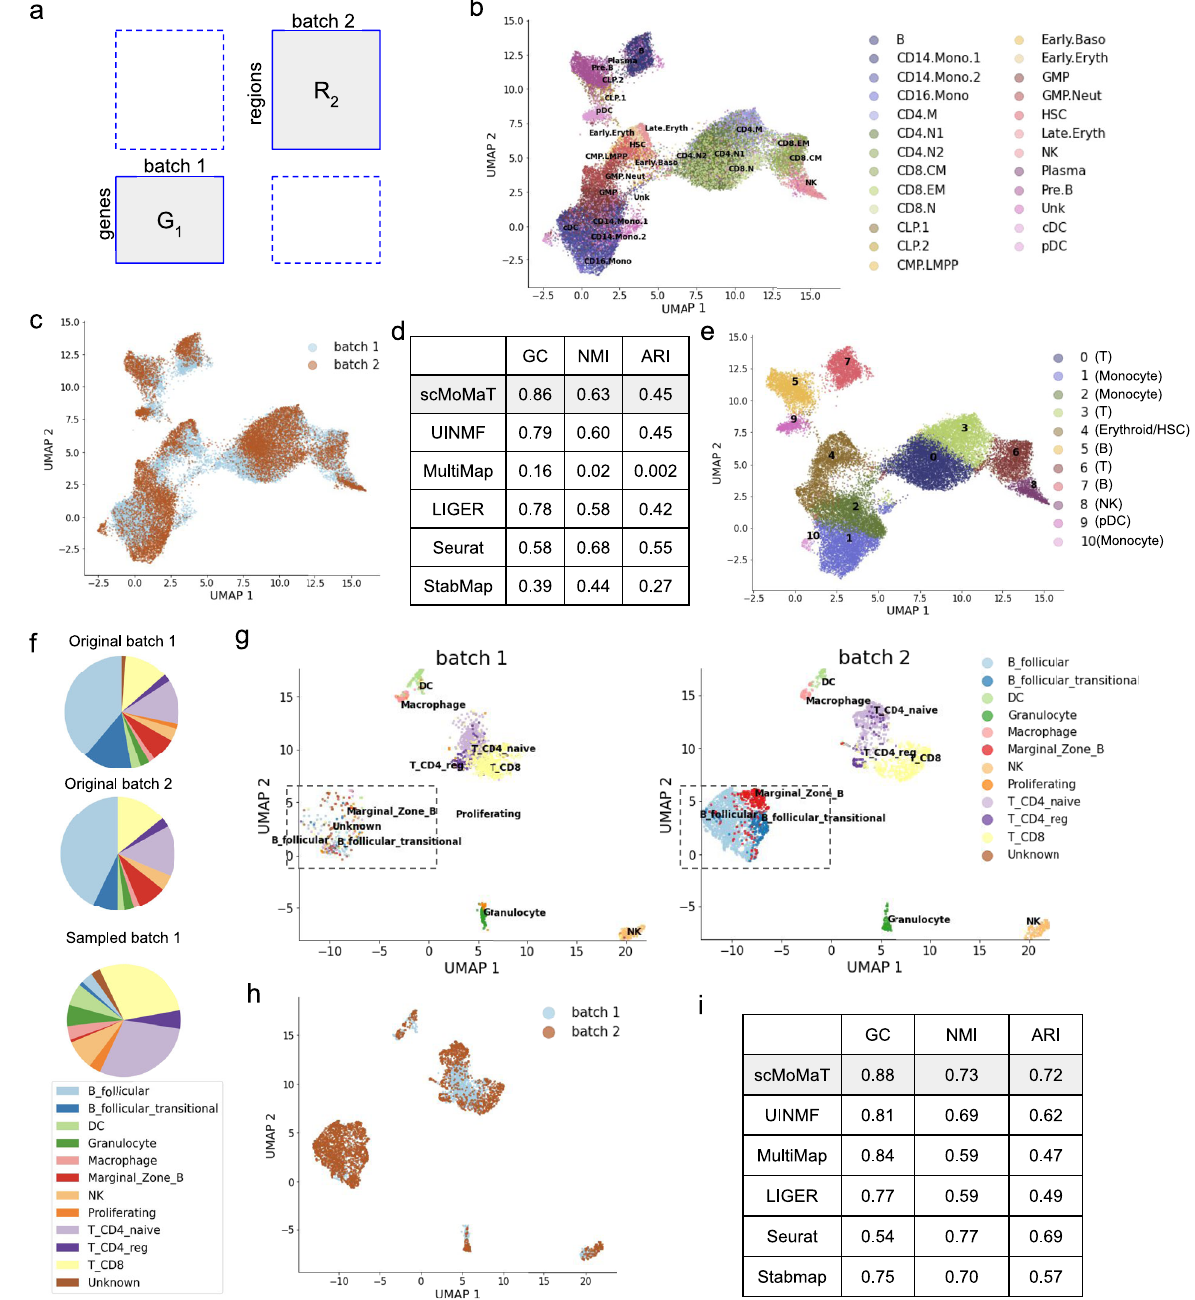
Fig. 6 | Results on the human bone marrow and mouse spleen dataset. a Relationship between data matrices in the two datasets. The UMAP visualization of cell factors, where cells are colored by ( b ) ground truth cell type, and ( c ) data batches. d The GC, ARI, and NMI scores of scMoMaT and baseline methods. e The UMAP visualization of cell factors, where cells are colored by Leiden clusters (with scMoMaT-annotated cell types). f The cell type composition of each batch in ori- ginal and subsampled mouse spleen dataset. g The UMAP visualization of cell